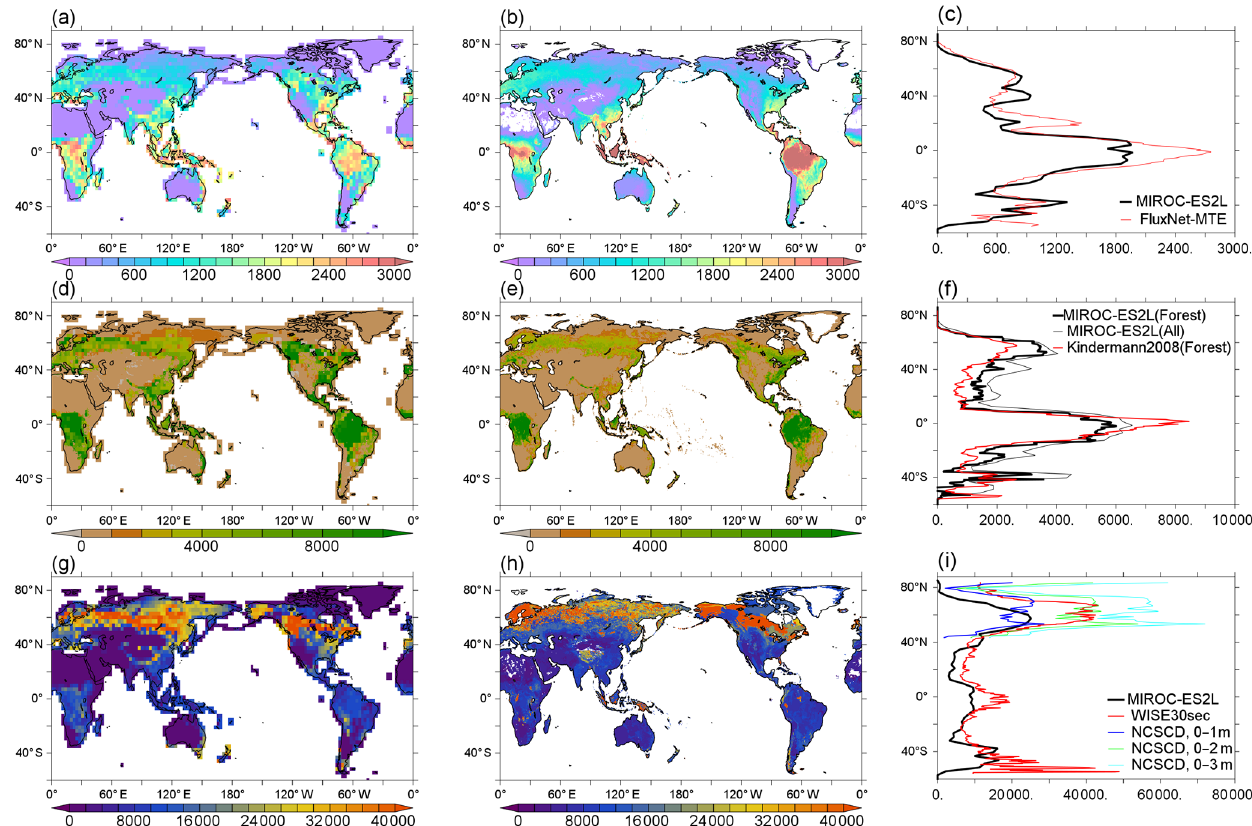
Figure 10. Comparison of the carbon flux and storage of the land ecosystem between the HIST simulation by MIROC-ES2L and an observation-based dataset. (a–c) A comparison of GPP (gCm − 2 yr − 1 ) averaged over 1982–2011: (a) model result, (b) FluxNet-MTE of Jung et al. (2011), and (c) zonally averaged distributions. (d–f) Vegetation carbon (gCm − 2 ): (d) model result of forest carbon (obtained by masking the total vegetation carbon where forest coverage is < 5%), (e) forest carbon estimated by Kindermann et al. (2008), and (f) zonally averaged distributions; solid black and red lines represent forest carbon, and the dashed thin line is the total vegetation carbon simulated by the model. (g–i) SOC (gCm − 2 ): (g) model result, (h) observation-based product of harmonized soil property values for broad-scale modeling (WISE30sec) by Batjes (2016), and (i) zonally averaged distributions in which the model result and WISE30sec are shown by black and red lines, respectively. Blue, green, and light blue lines in panel (h) are NCSCDv2 by Hugelius et al. (2013), which is an independent estimate of SOC in the high-latitude region of the Northern Hemisphere at different soil depths (blue: 0–1m, green: 0–2m, light blue: